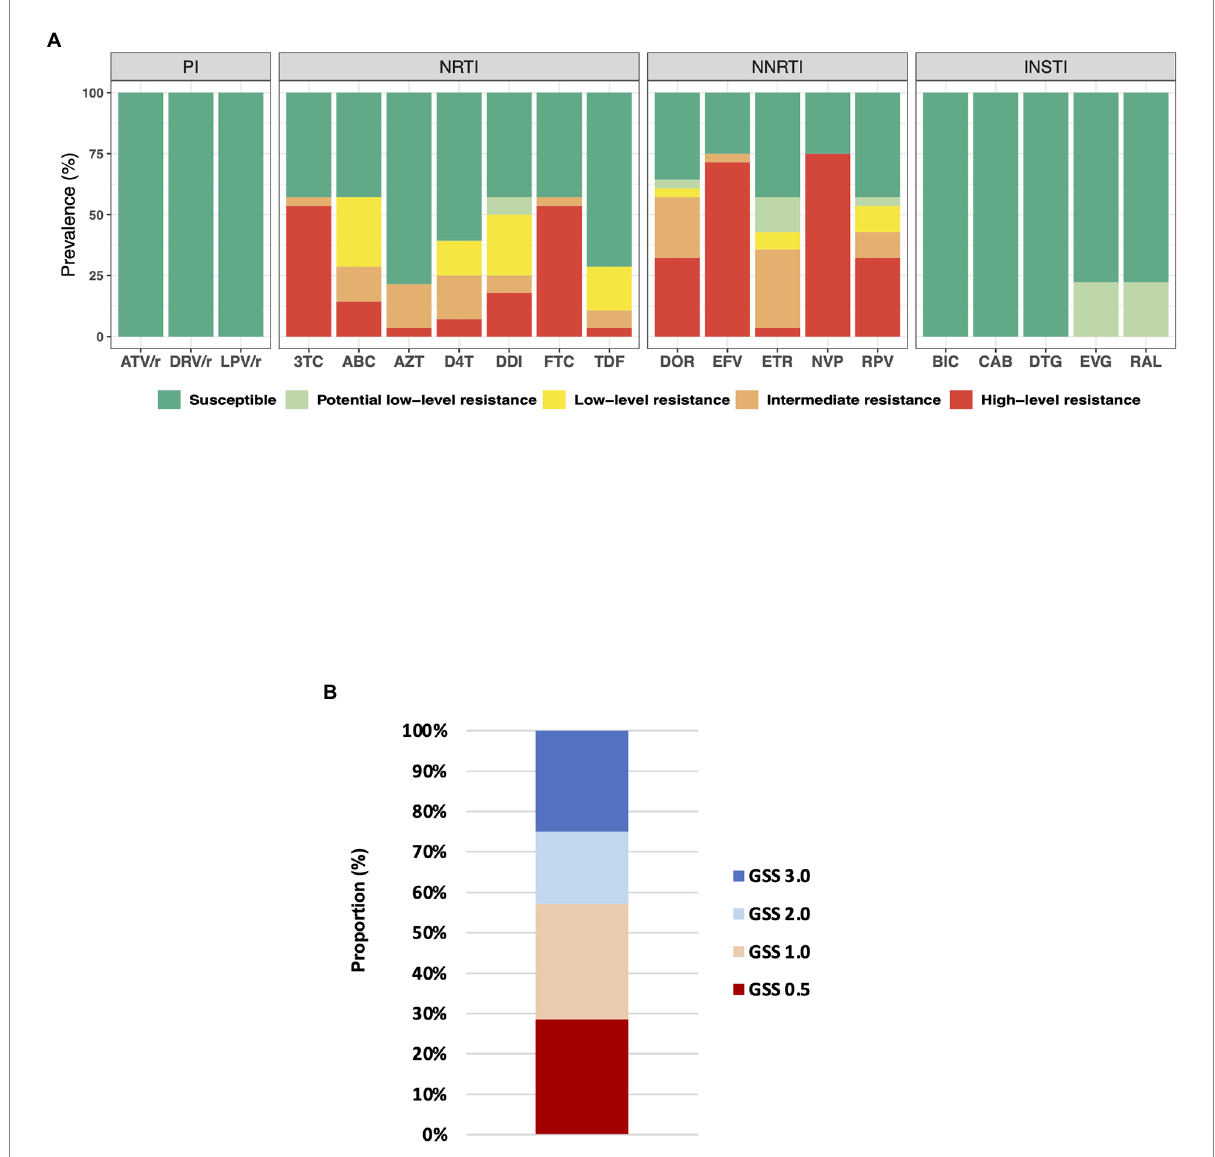
FIGURE 2 (A) Drug resistance profile in ART-experienced individuals. Drug resistance mutations were interpreted using Stanford University HIV drug resistance database version 9.0. ATV/r, ritonavir-boosted Atazanavir; DRV/r, ritonavir-boosted Darunavir; LPV/r, ritonavir-boosted Lopinavir; 3TC, lamivudine; ABC, Abacavir; AZT, zidovudine; D4T, Stavudine; DDI, Didanosine; FTC, Emtricitabine; TDF, Tenofovir disoproxil fumarate; DOR, Doravirine; EFV, Efavirenz; ETR, Etravirine; NVP, nevirapine; RPV, Rilpivirine; BIC, Bictegravir; CAB, Cabotegravir; DTG, Dolutegravir; EVG, Elvitegravir; and RAL, Raltegravir. (B) Genotypic susceptibility score (GSS) for ART-experienced participants; n = 28. The GSS was obtained using the Stanford University HIV genotypic resistance interpretation system. We classified patients as follows; No resistance or potential